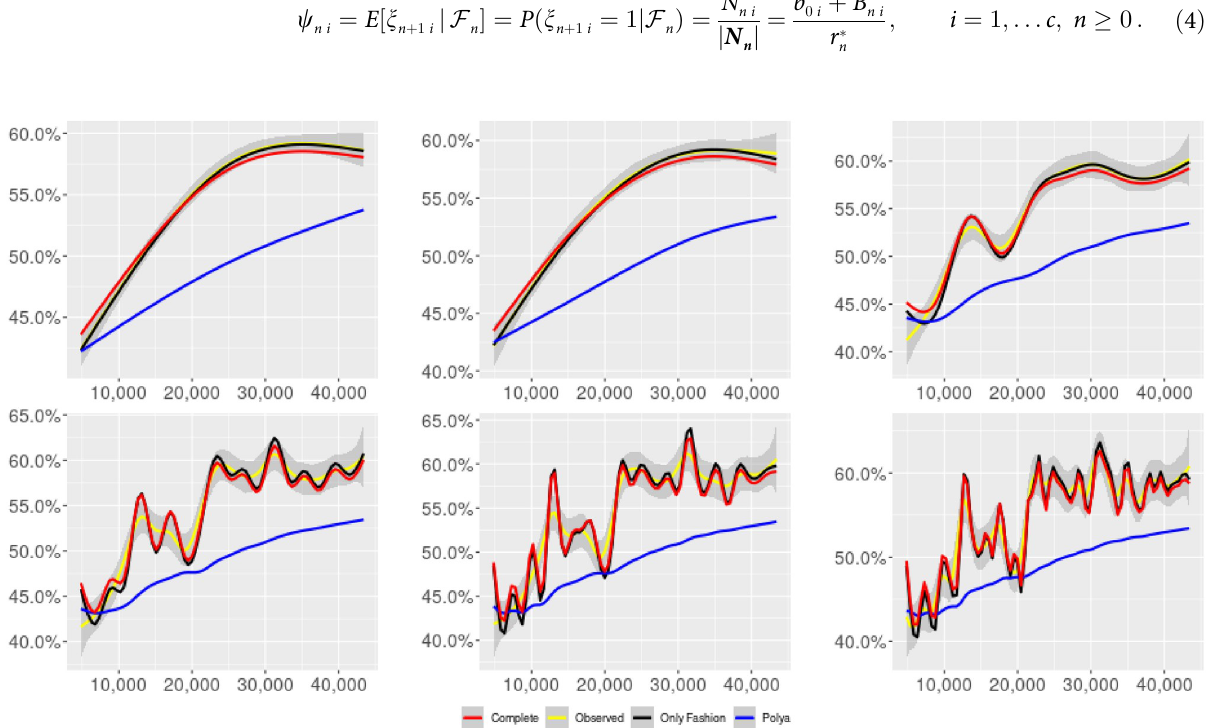
Fig 6. “Covid” ( T = 0.35, only BOTs’ posts, D 0 = 3, S = 1000 slots of equal size): Sentiment curves for BOTs’ posts. In each panel, the yellow line is the cubic spline smoothing of the time series of the observed tweets ξ , together with the default confidence interval (gray), the red line represents the n +1 cubic spline smoothing of the time series of the estimated predictive means ^ c (defined in Subsec. 3.2), obtained with the complete RP model, the black n and the blue lines provide similar approximations obtained with the other models: black = Only fashion RP model and blue = Standard Po´lya model. In each panel, the smoothing is obtained with a given number of nodes: k = 3 (top left panel), 5 (top middle panel), 10 (top right panel), 20 (bottom left panel), 30 (bottom middle panel), 50 (bottom right panel).